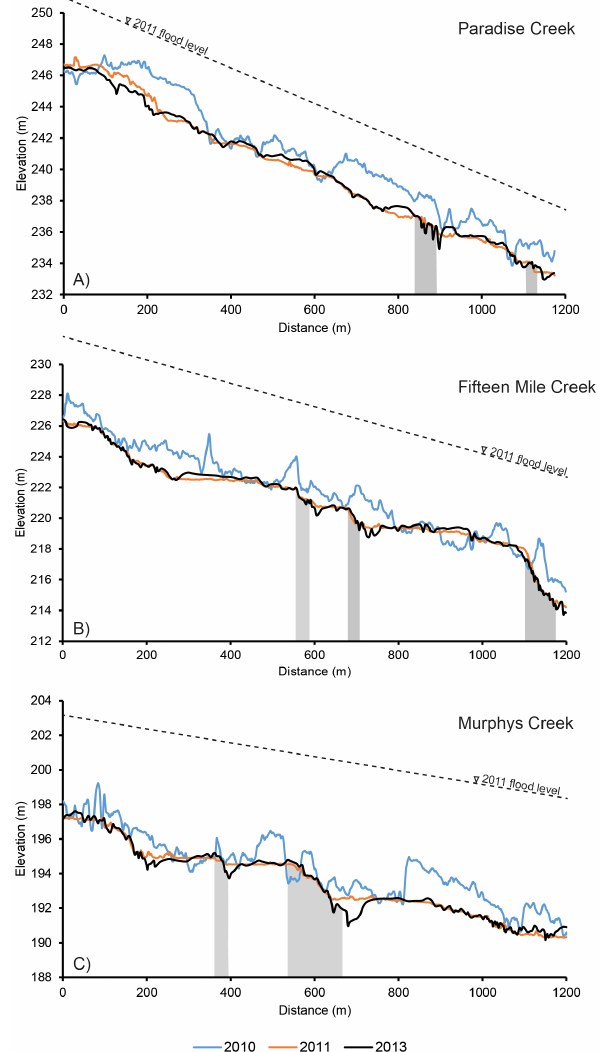
Figure 5. Longitudinal profiles of the three field sites: (a) Paradise Creek, (b) Fifteen Mile Creek and (c) Murphys Creek. Derived from 2010 and 2011 lidar (pre- and post-2011 flood) and 2013 normalised DGPS thalweg profile (post-2013 flood). Dashed black line repre- sents average water surface profile for the January 2011 flood based on DGPS elevations of flood marks. Grey shaded bars in each pro- file highlight exhumation of bedrock steps in the 2011